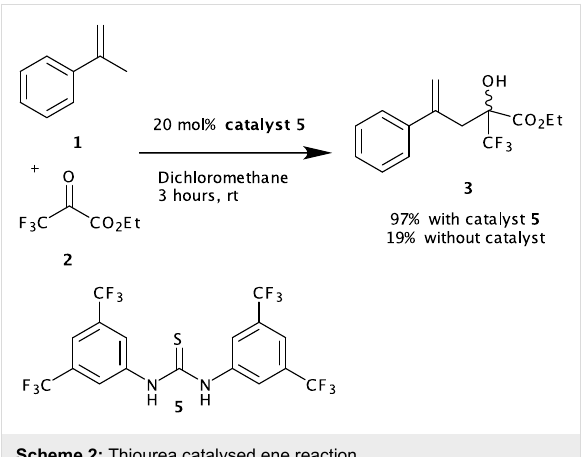
Scheme 2: Thiourea catalysed ene